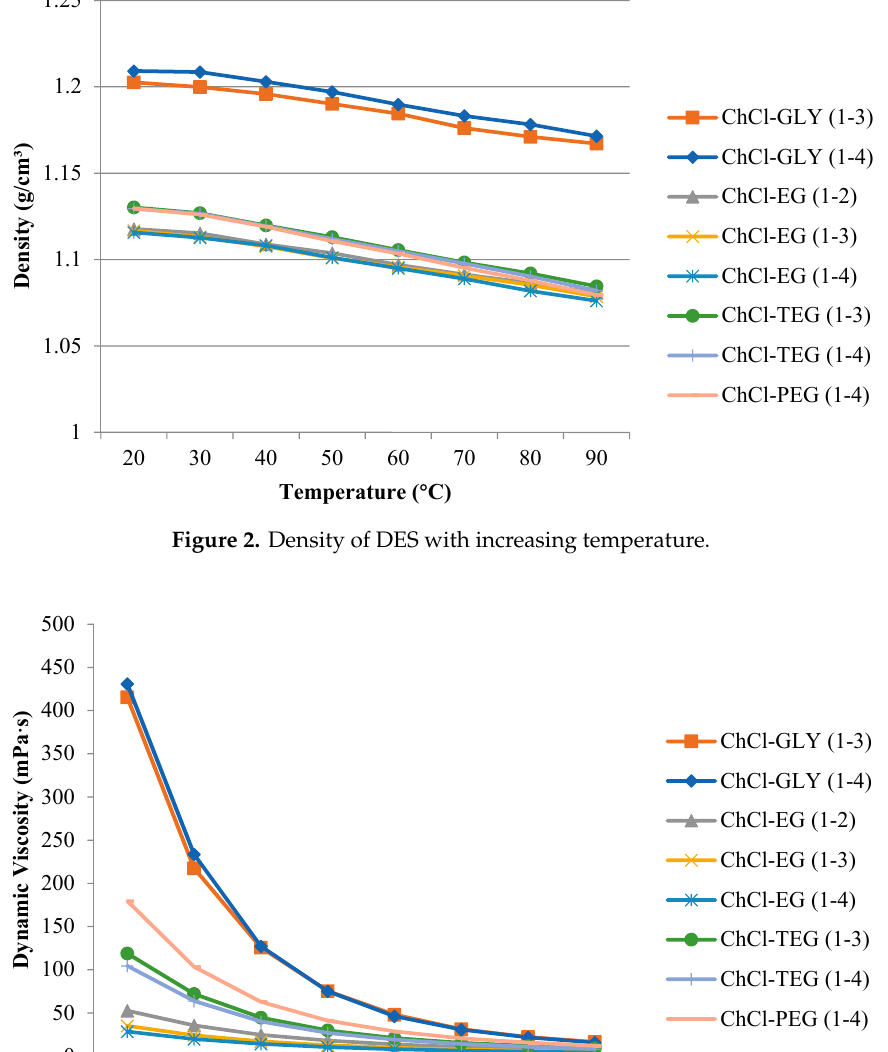
Figure 2. Density of DES with increasing temperature.